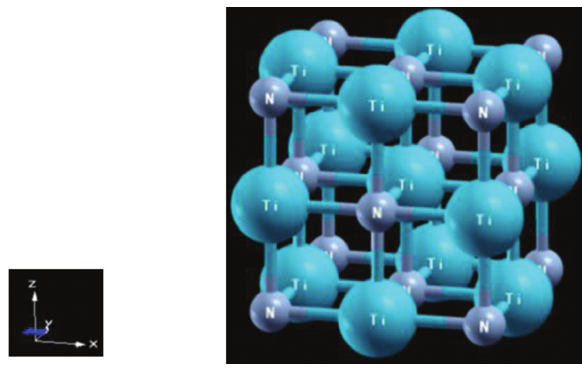
Figure 1: Crystal structure of TiN phase